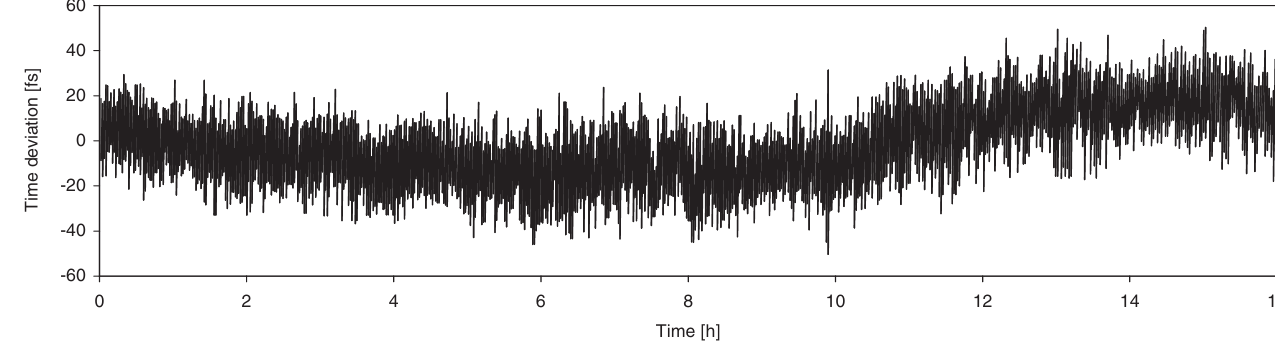
FIG. 14. Time deviation between the phase displacement, determined by the delay measurement and the control